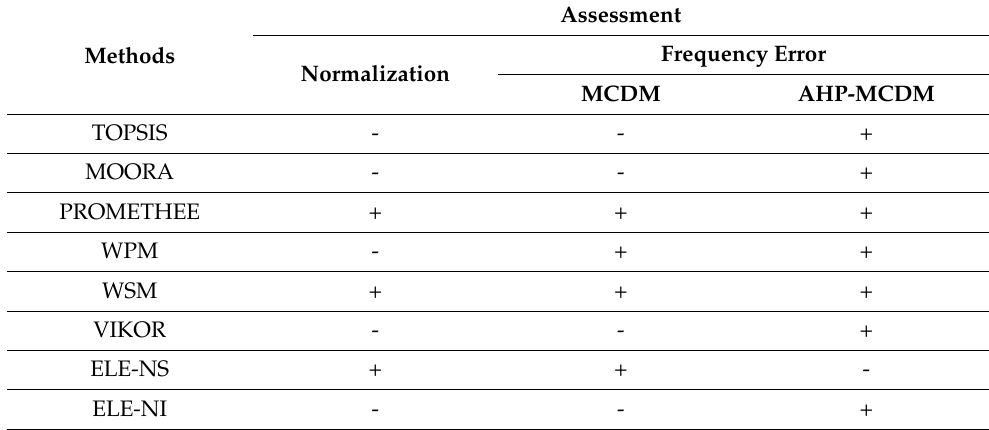
Table 9. Comparative analysis of MCDM.